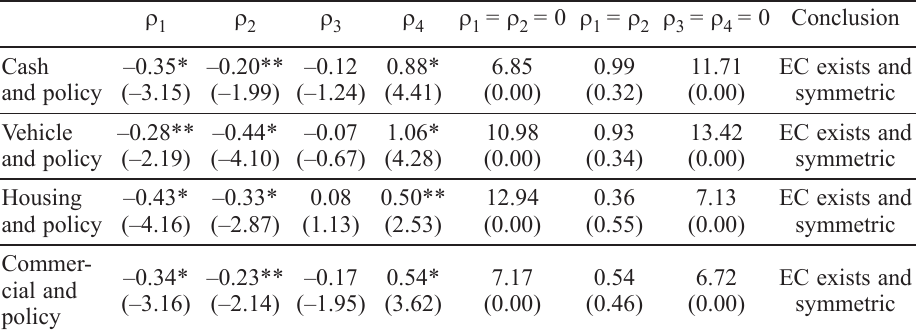
Table 5. Coefficients of EC models – TAR specification ( τ =